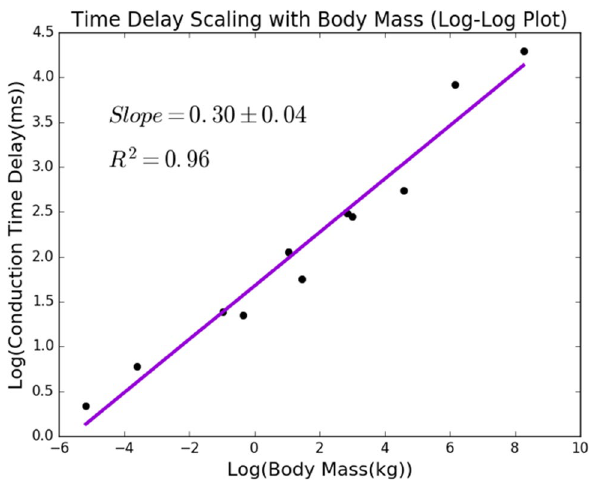
Figure 5. Scaling of conduction time delay and species mass. A scatter plot showing the relationship between the log of the conduction time delay and the log of the body mass of a range of species. Here, the slope, 0.30 ± 0.04 , corresponds to the power that relates species mass to conduction time delay. This is close to our theoretical result of 1 4 (=